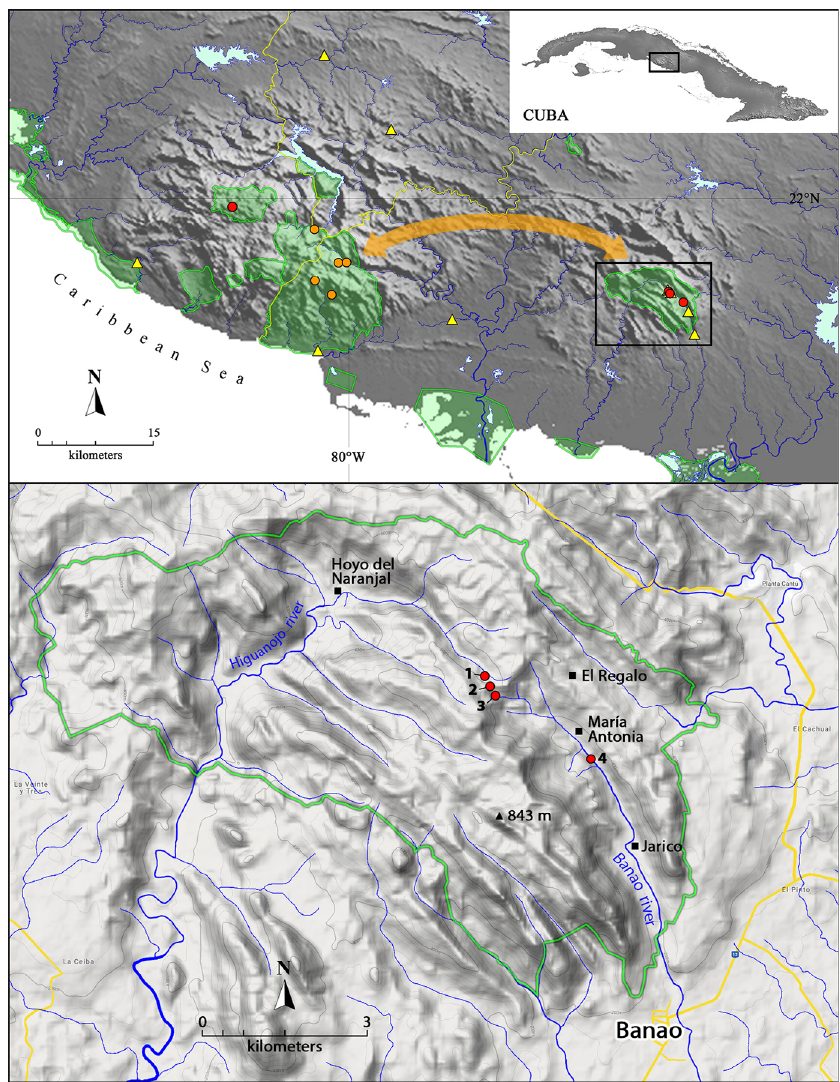
Figure 1. Distribution of Epilobocera capolongoi (circles) and E. cubensis (triangles) in central Cuba, depicting the previous records (orange circles) and new records (red circles) of E. capolongoi : 1) Tributary source of Higuanojo river, 2) La Sabina ranger station, 3) tributary source of Banao river, and 4) Banao river, near María Antonia ranger station; the westernmost new record (above) corresponds with Pico San Juan Ecological Reserve. Green shadings and contours depict protected areas. The two-headed orange arrow depicts the narrow strip of heights connecting the Trinidad Heights in the west and the Sancti Spíritus Heights in the east, assumed here as a putative communication pathway between the two presumably allopatric subpopulations of E. capolongoi